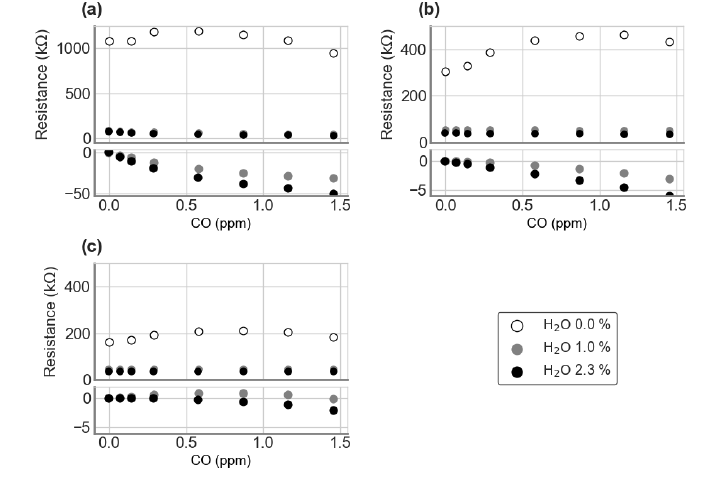
Figure 2. Measured sensitivity of Figaro ® sensors ( a ) TGS 2600, ( b ) TGS 2611-C00 and ( c ) TGS 2611-E00 to CO, at different humidity levels. Upper plots show the measured resistance, while lower plots show the contribution to the resistance due to CO.